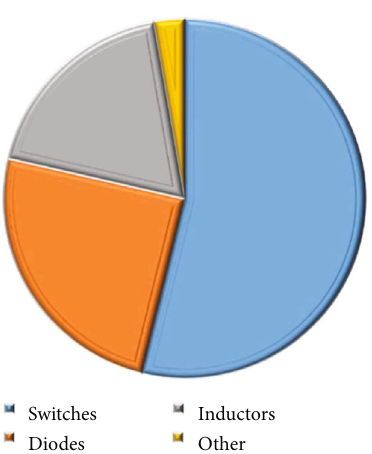
Table 3: Loss distribution.